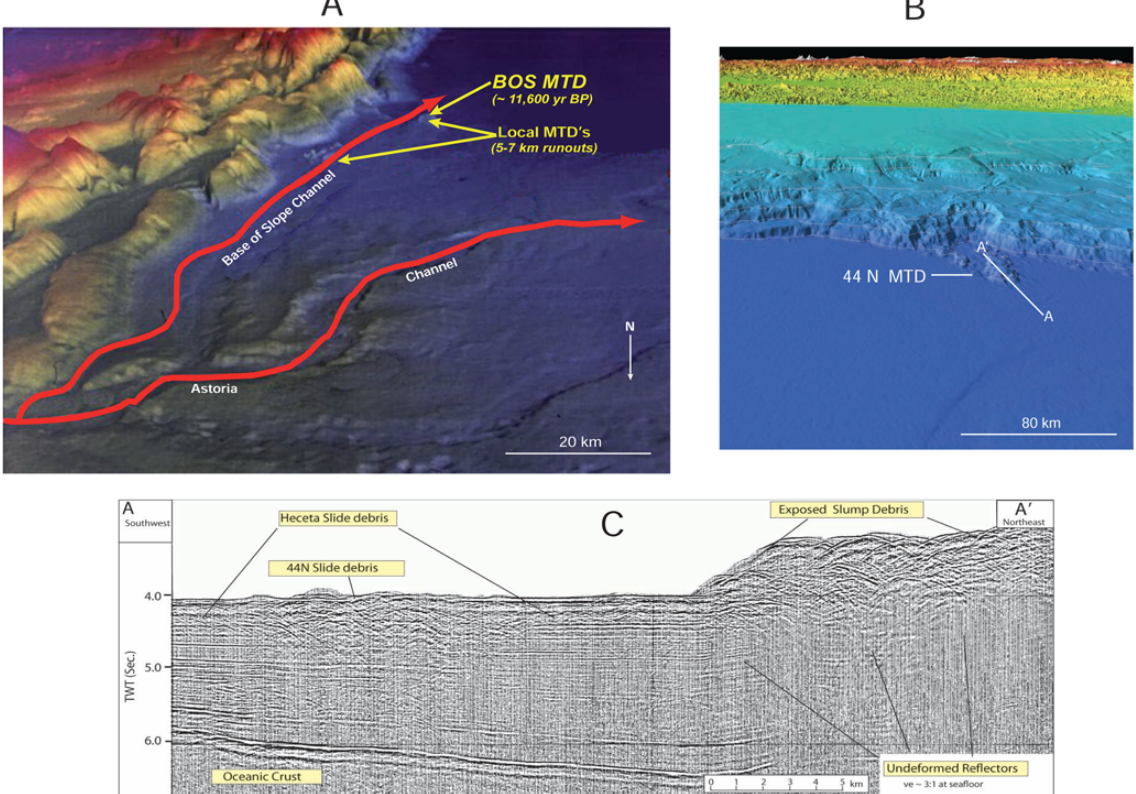
Fig. 8. (A) This 3-D swath bathymetric image looks southward from Astoria Canyon mouth over the Oregon continental slope and northern Astoria Fan. The red to yellow depth coloration highlights the shallower depths of the accretionary folds on the lower slope. The blue and brown colors highlight the channel pathways of Astoria Fan. Red lines trace the axial pathway of the Astoria Channel and base-of-slope channel, where two MTD slump debris lobes block the channel and run out about 5–7km out from the slope base. (B) This 3-D swath bathymetric image looks landward towards the central Oregon continental slope and shows that the 44 N MTD (mass transport deposits) run out approximately 25km from the slope base. (C) This seismic profile shows that the 44 N surface and Heceta subsurface MTDs have maximum run out distances for approximately 25km from the base of the continental slope. The locations of (A) , (B) and (C) are shown in Fig. 3. ( A is modified from Nelson et al., 2000, B is modified from Goldfinger et al., 2012 and C is from Goldfinger et al.,